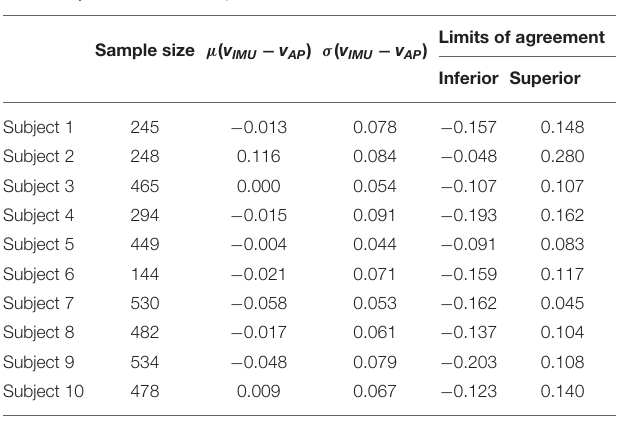
TABLE 3 | Bland-Altman analysis.